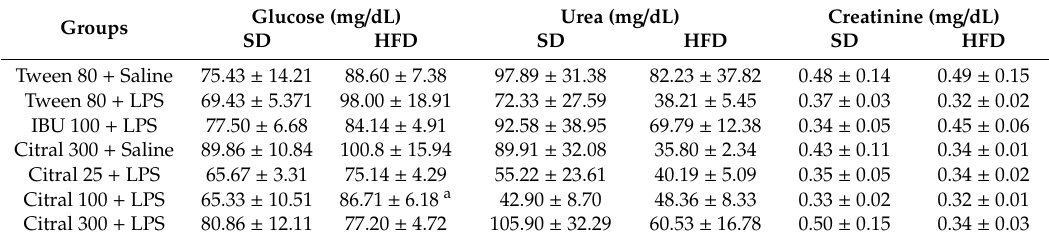
test. Two-way ANOVA followed by Bonferroni’s test; a = p < 0.05, compared to the SD mice.